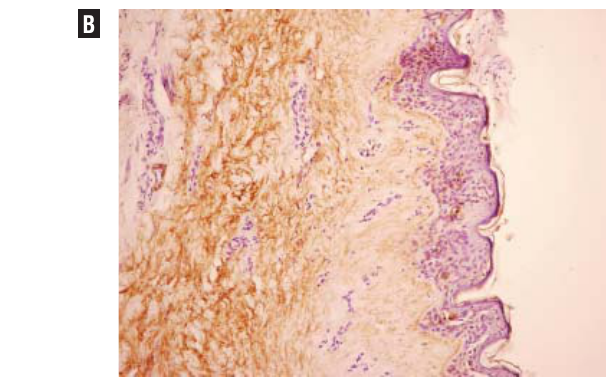
Figure 2 - Analysis of the elastic fi bers: A) Photomicrography of the prepuce of a 3-year old patient not treated with topical steroid. It is possible to observe that the elastic fi bers (purple) are distributed over the whole fi eld. Weigert stain reduced X400. B) Photomicrography of the prepuce of a 3-year old patient submitted to topical steroid treatment. It is possible to oberserve the elastic fi bers (purple). Weigert stain reduced X400.